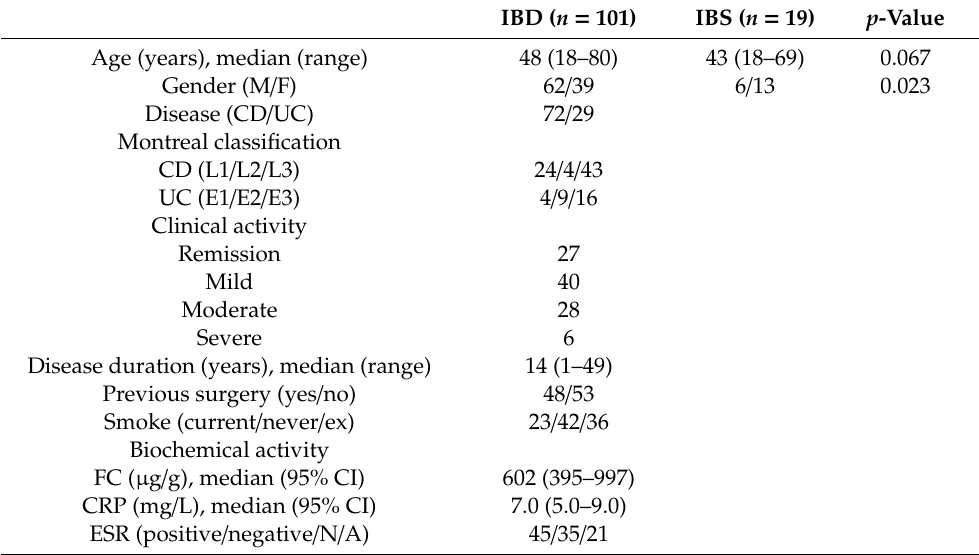
Table 1. Characteristics of the study population included in the cross-sectional